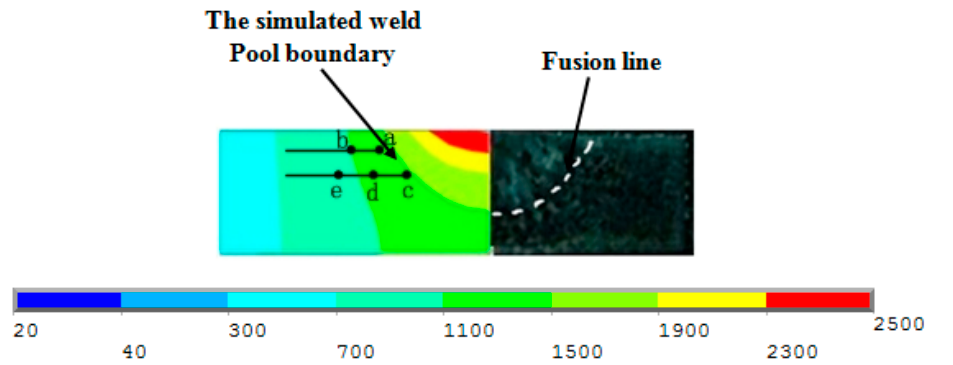
Figure 7. Comparison of the predicted weld profile (left side) and that experimentally obtained (right side).